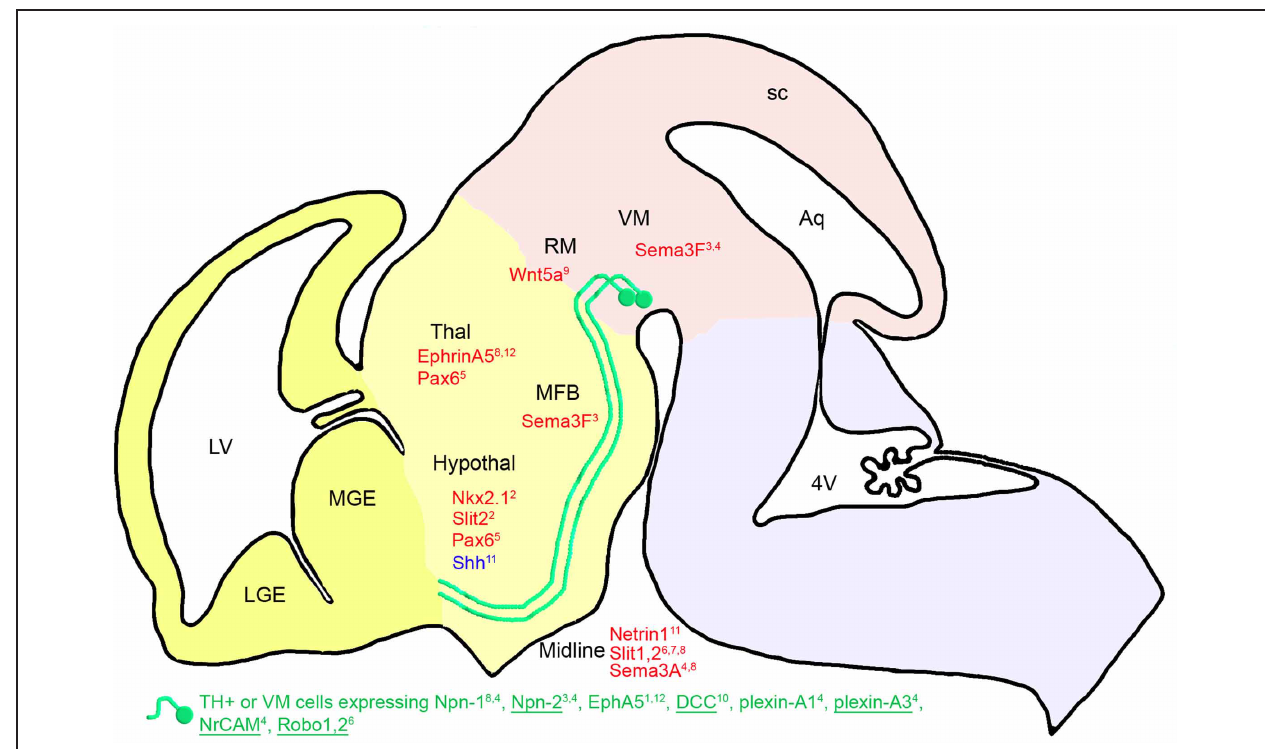
FIGURE 2 | Diencephalic guidance: expression of repulsive (in red) and attractive (in blue) guidance cues in the environment of mDA somas and axons at E13.5 in mice. mDA axons (in green) fasciculate in a ventrorostral direction to form the MFB. mDA axons respond to environmental cues through specific receptors (in green). Receptors expressed in all or most of the midbrain TH-expressing cells (TH+) are underlined, whereas receptors expressed in a small fraction of TH-expressing neurons are not. The expression of these receptors has been determined either at the mRNA or the protein level around E13.5 (see details in the text). Nkx2.1 has an indirect repulsive action on mDA axons through the activation of Slit-2 expression. Pax6 allows the mDA fibers to navigate ventrally through the